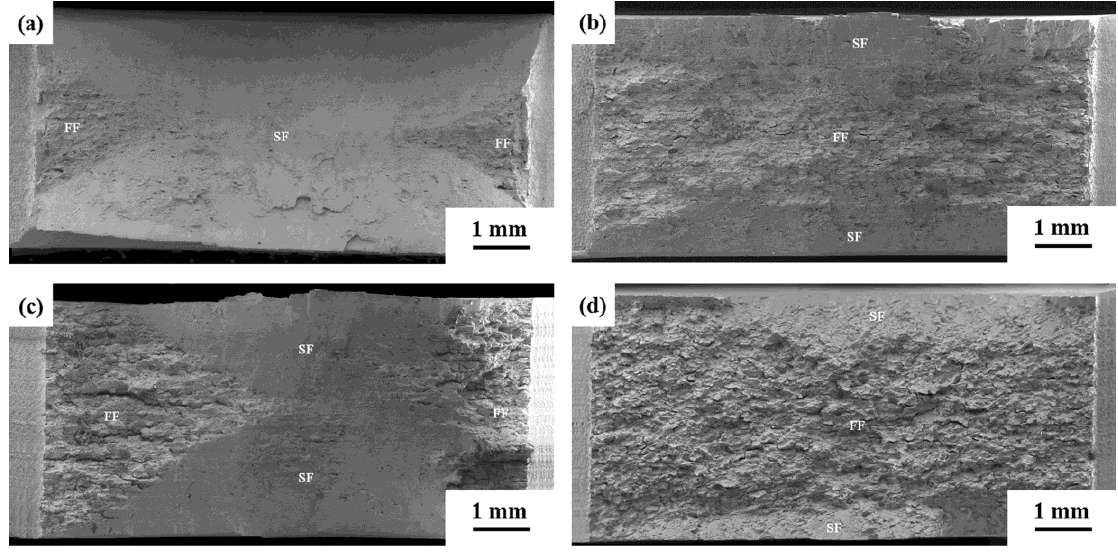
Figure 4. Macro-fracture appearances of ( a ) CR-300, ( b ) CR-450, ( c ) CR-300H, and ( d ) CR-450H specimens.